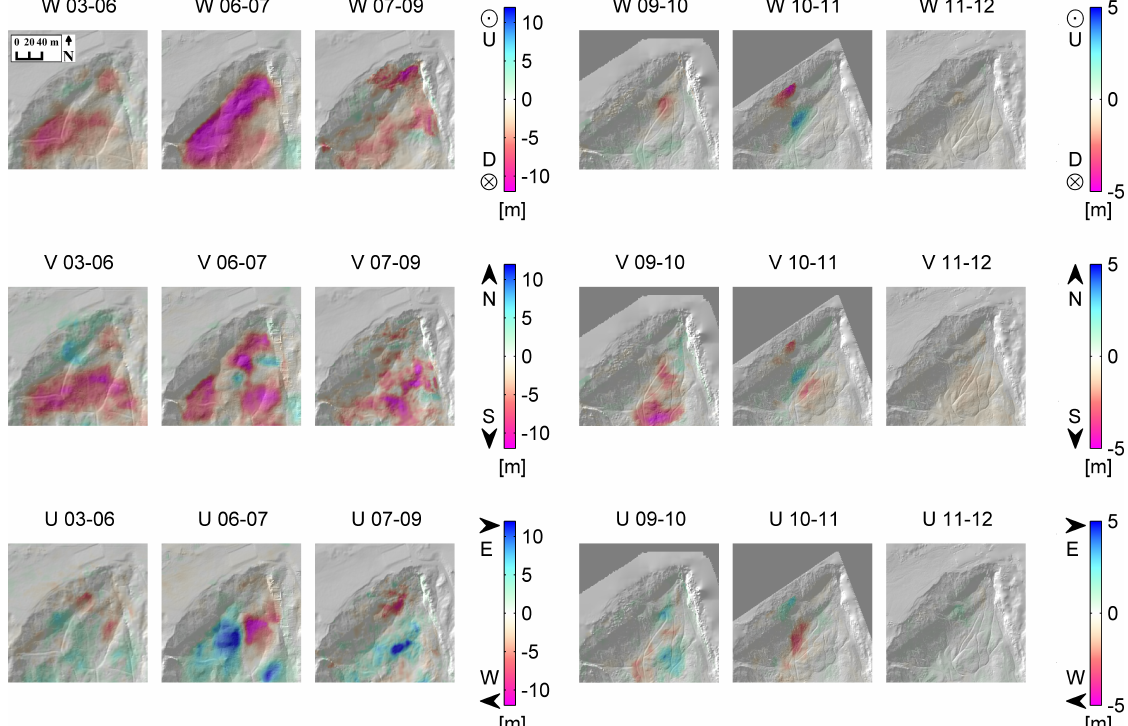
Figure 8. Motion vectors from 2003 to 2012 overlaid over the respective digital terrain models (DTMs) in the scarp area of the